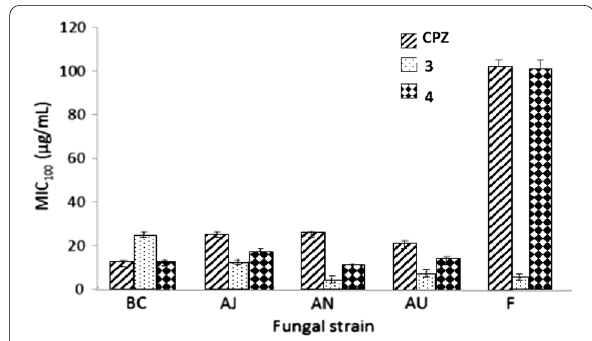
Fig. 3 Antifungal activity of compounds 3 , 4 and CPZ against filamentous fungi. Fungal strains: BC : Botrytis cinerea ; AJ: Aspergillus japonicus ; AN: Aspergillus niger ; AU: Aspergillus ustus ; F: Fusarium